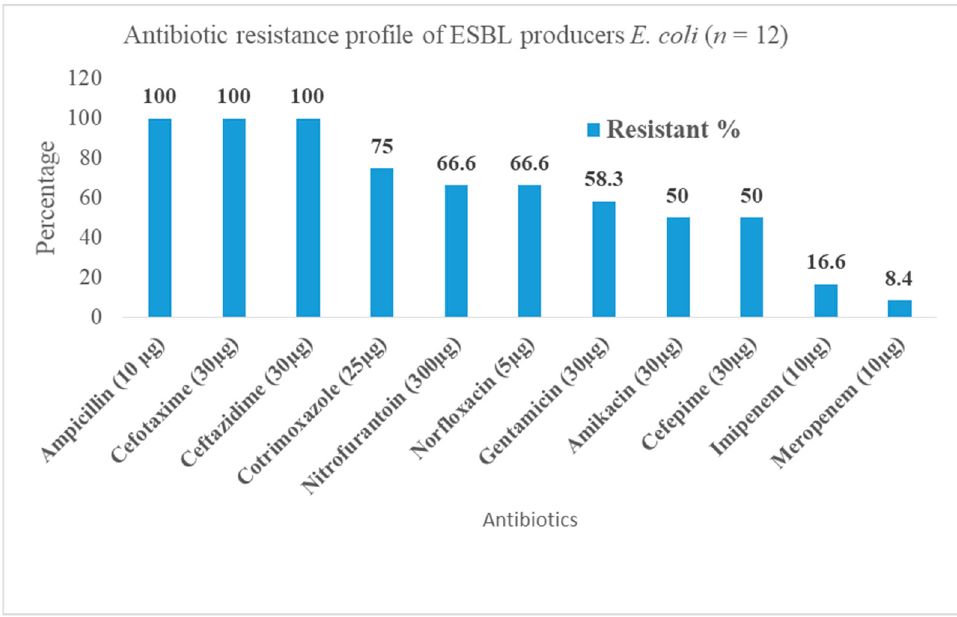
Figure 2. Antibiotic resistance profile of ESBL producers E.